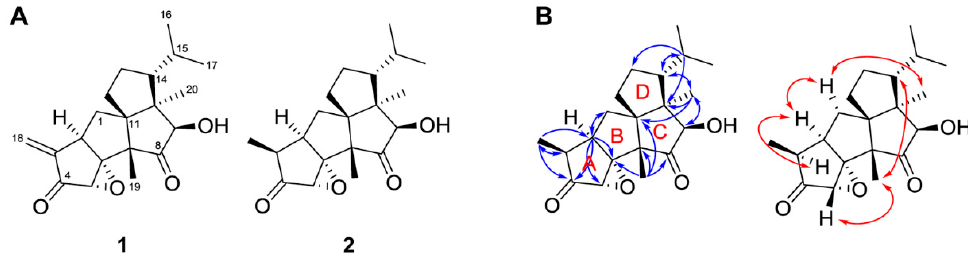
Figure 5. A : Structures of 1 and 2 ; B : Key HMBC (blue arrow) and ROESY (red arrow) correlations of 2 Figure 5. A . Structures of 1 and 2 .; B : Key HMBC (blue arrow) and ROESY (red arrow) correlations of 2 .